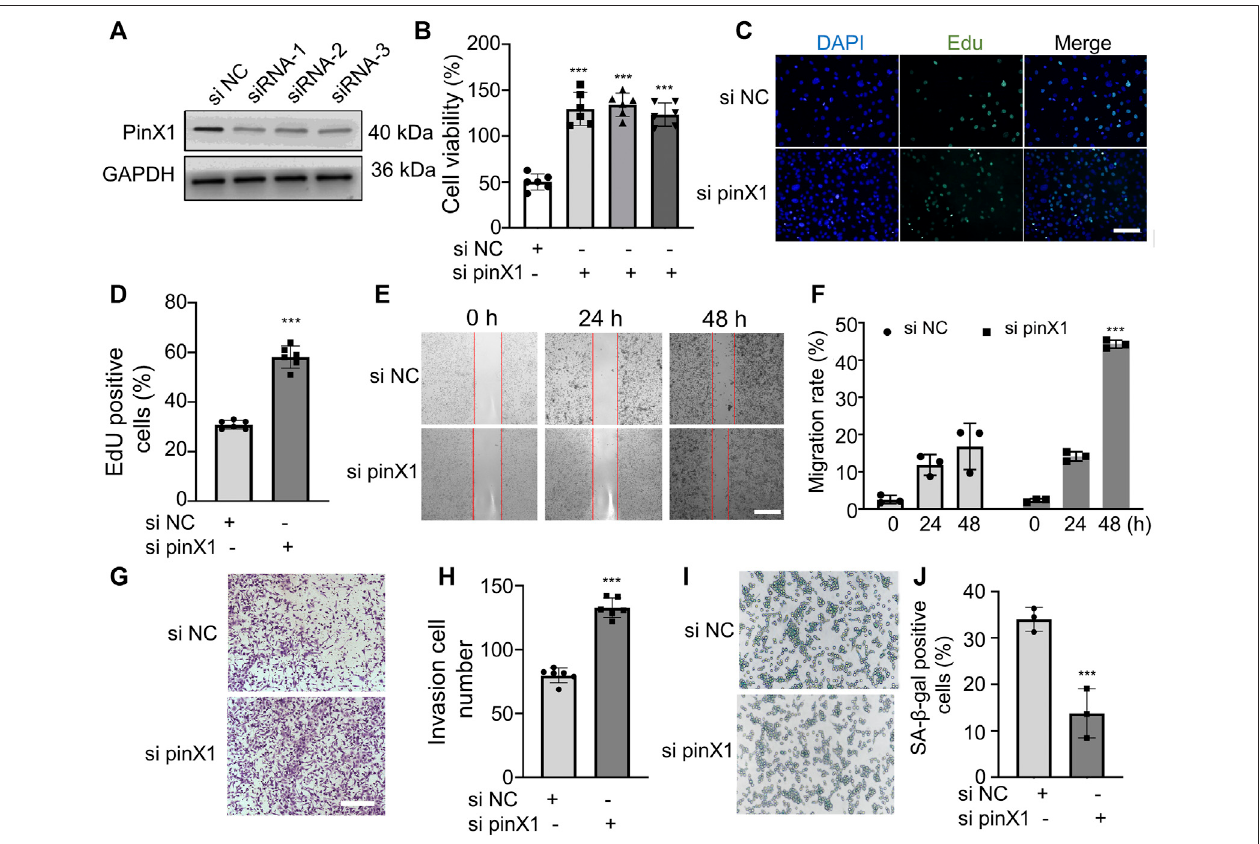
FIGURE 3 | Lack of pinX1 protein expression promoted LLC cell proliferation, invasion, and migration and inhibited cell senescence. (A) PinX1 expression. (B) Cell viabilityassay. (C) and (D) EdUstaining. (E) and (F) Woundhealingassay. (G) and (H) Transwellinvasionassay. (I) and (J) SA- β -galstaining. n =3or5;dataareshownas mean ± SD. *** p < 0.001 compared with si